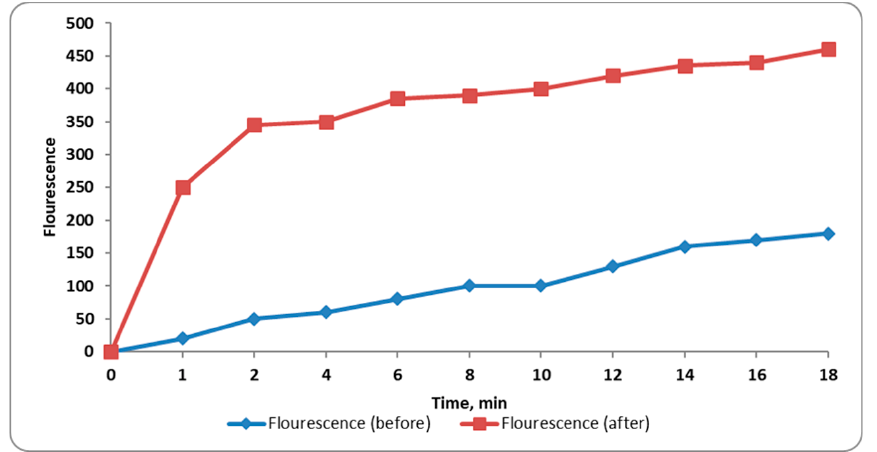
Figure 5. A chart showing the increase in the outer membrane permeability of a representative S. enterica isolate after treatment with CRME was detected by determining the fluorescence of NPN against